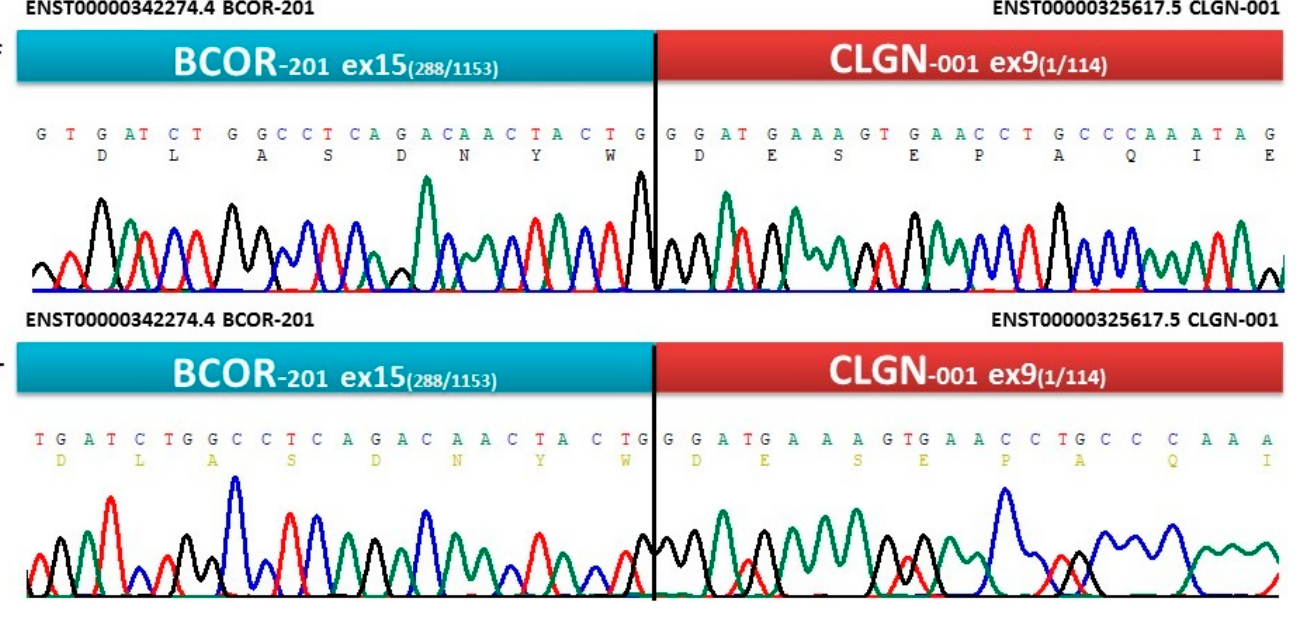
Figure 3. Bidirectional Sanger-sequencing electropherogram showing the nucleotide sequence at the breakpoint of BCOR - CLGN gene fusion. Note: f: forward direction, r: reverse direction.